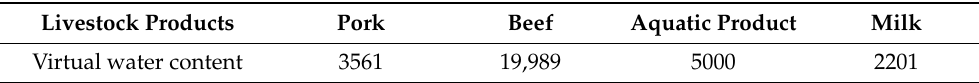
Table 1. The virtual water content of principle livestock products (m 3 · t − 1